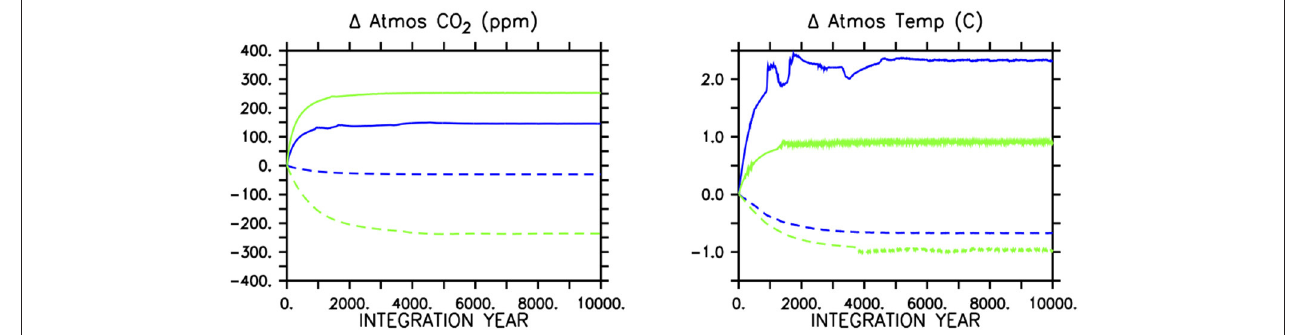
FIGURE 4 | Atmospheric CO 2 response (left panel) in icehouse (blue lines) and greenhouse (green lines) to removing all soft-tissue production and calcification (solid lines) or calcification only (dashed lines). The concurrent response of globally averaged atmospheric temperature is shown in the (right panel)